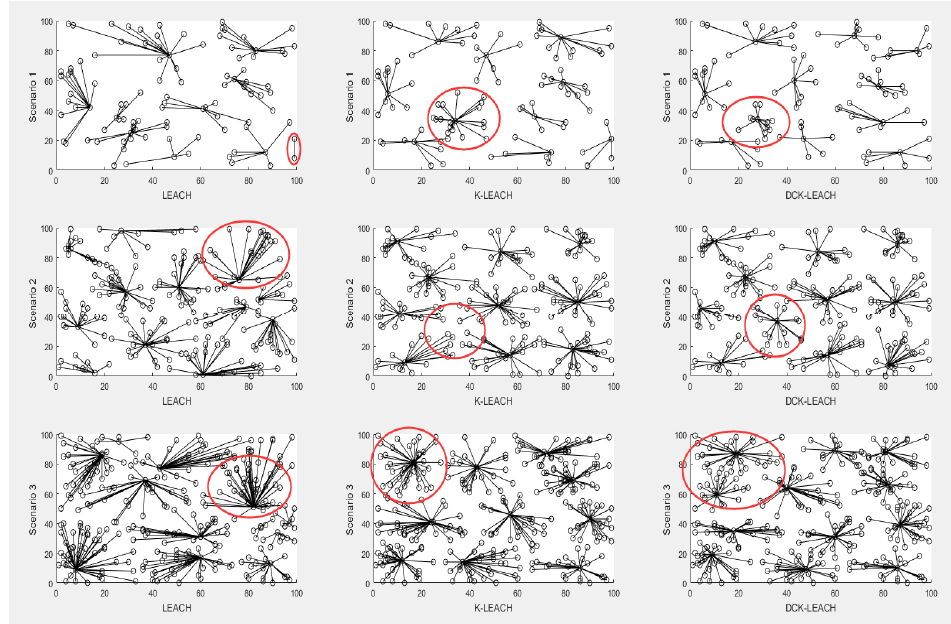
Figure 3. The first round of clustering results in scenario 1, 2, and 3.